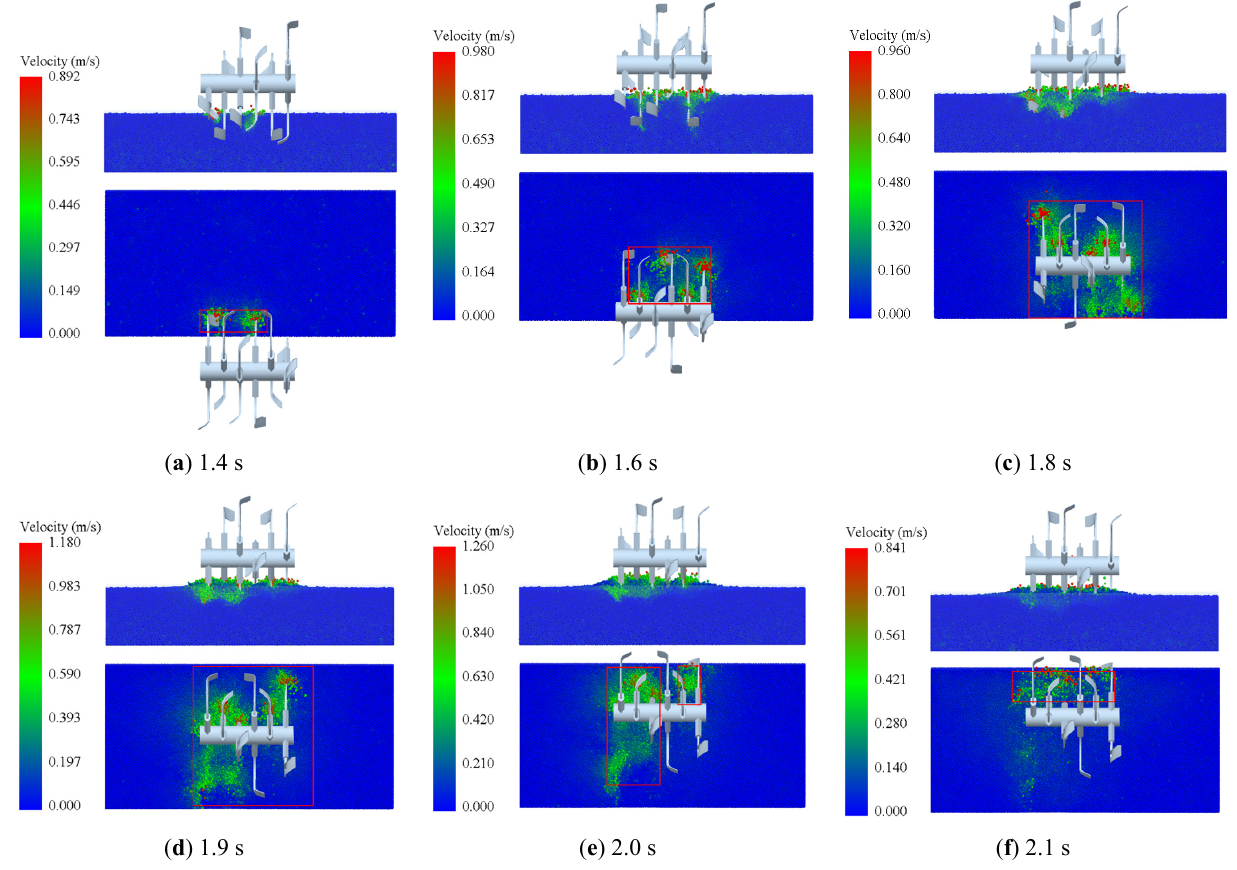
Figure 9. Cutting process simulation diagram.